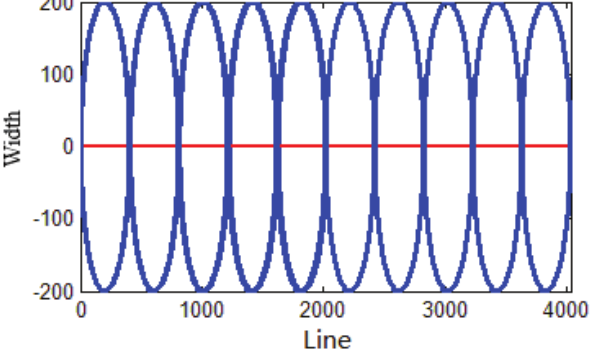
Figure 14: Case 1: The optimal line tunnel (L =